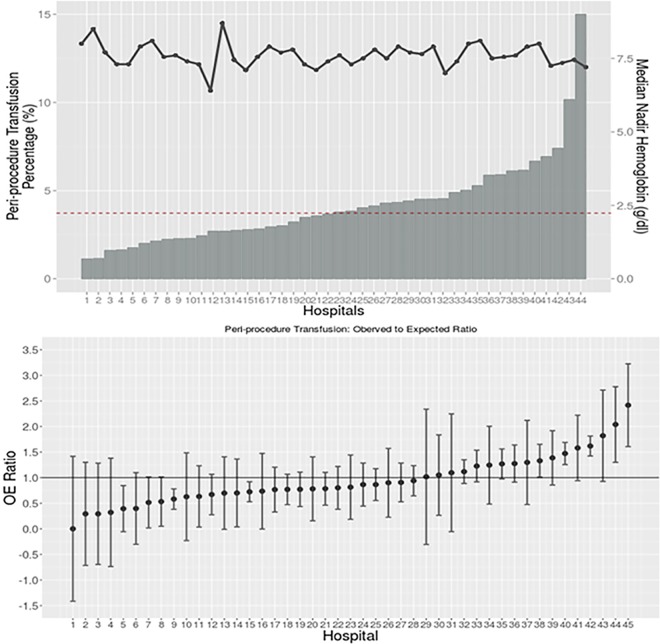
Hospital-wise peri-procedural transfusion distribution.Hospitals are blinded, and both plots may have different order. Two hospitals that had no transfusion were omitted in the both plots. (a) shows unadjusted rate of the transfusion and median nadir hemoglobin level among transfused patients in each BMC2 participating hospitals (blinded). The red dotted horizontal line is showing the median of peri-procedural transfusion rate (3.7%). (b) shows adjusted hospital-wise transfusion distribution using the developed risk model. A horizontal line is at OE ratio = 1.